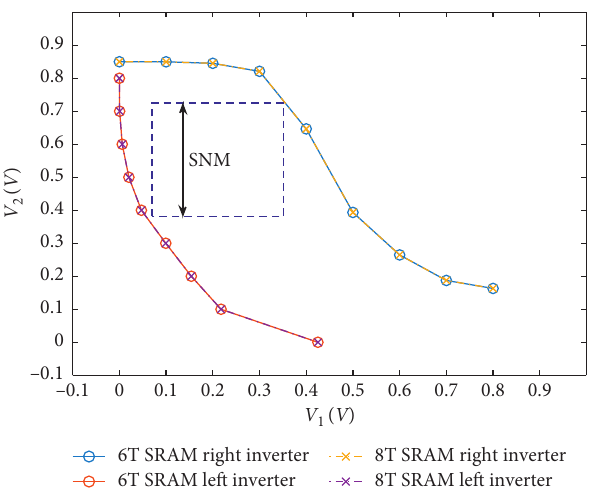
Figure 9: Butterfly curve of GNRFET-based 6T and 8T SRAM cells in the write mode.